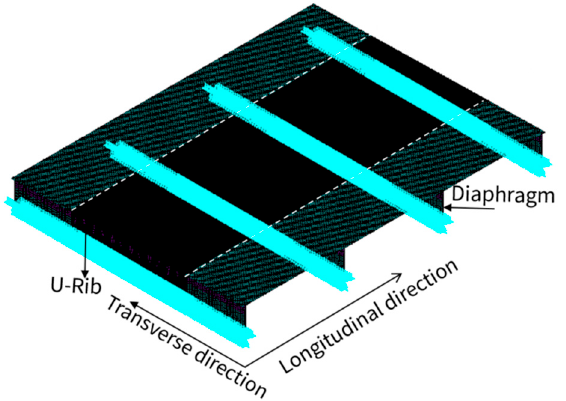
Figure 5. Finite element model.